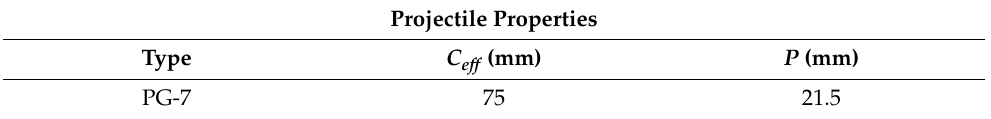
Table 7. Considered projectile properties for the ballistic efficiency